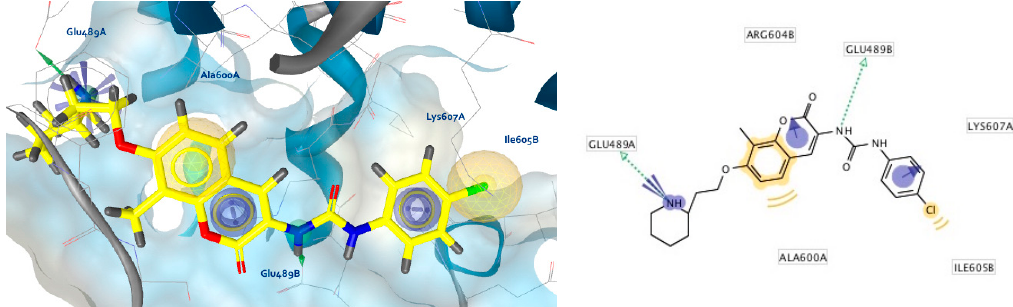
Figure 14. Interactions of compound S3 (Supplementary Table S1), an active novobiocin derivative, with the Hsp90 CTD binding site from the MD simulation used to derive the SB-model for virtual screening. The pharmacophore features are as follows: hydrophobics (yellow spheres), aromatics (blue discs), hydrogen bond donor (green arrow), positive ionizable (blue stars).